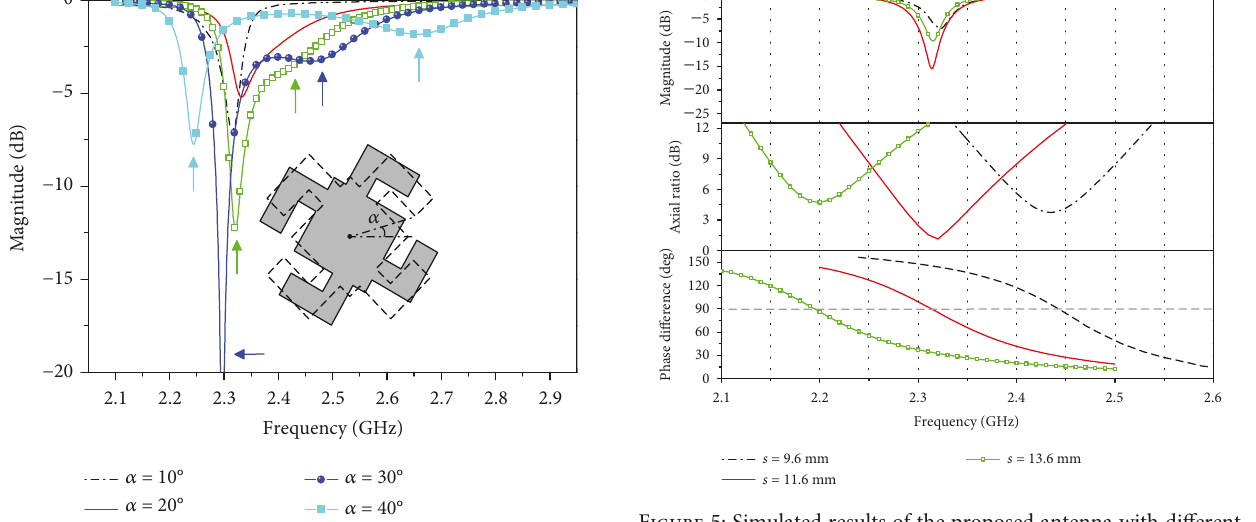
Figure 5: Simulated results of the proposed antenna with di ff erent distances s : re fl ection coe ffi cient, AR, and phase di ff erence of two resonant frequencies. Figure 3: Simulated re fl ection coe ffi cient of the proposed antenna